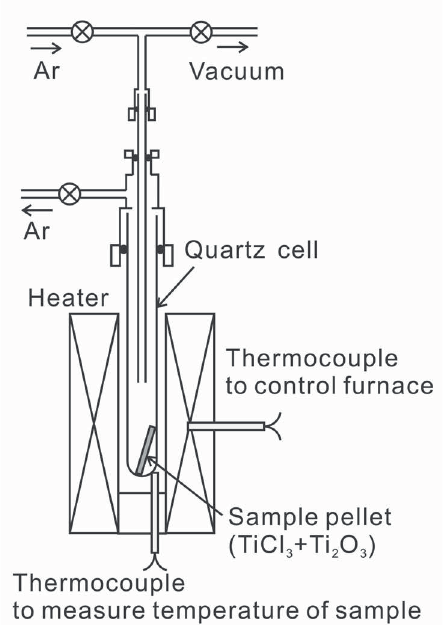
Figure 3. Schematic illustration of the set-up for synthesis of TiOCl.